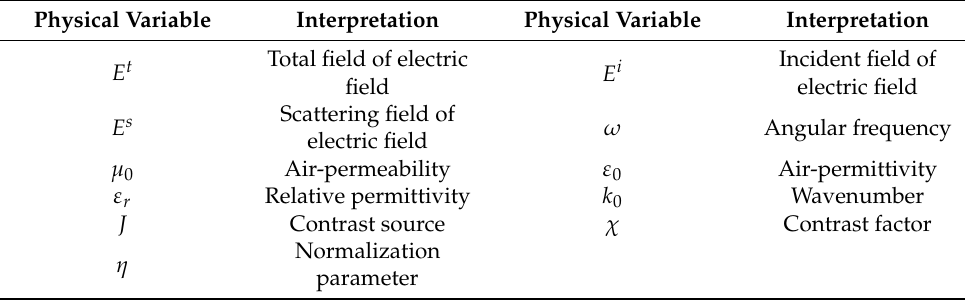
Table 1. The main physical variables and meanings involved in this